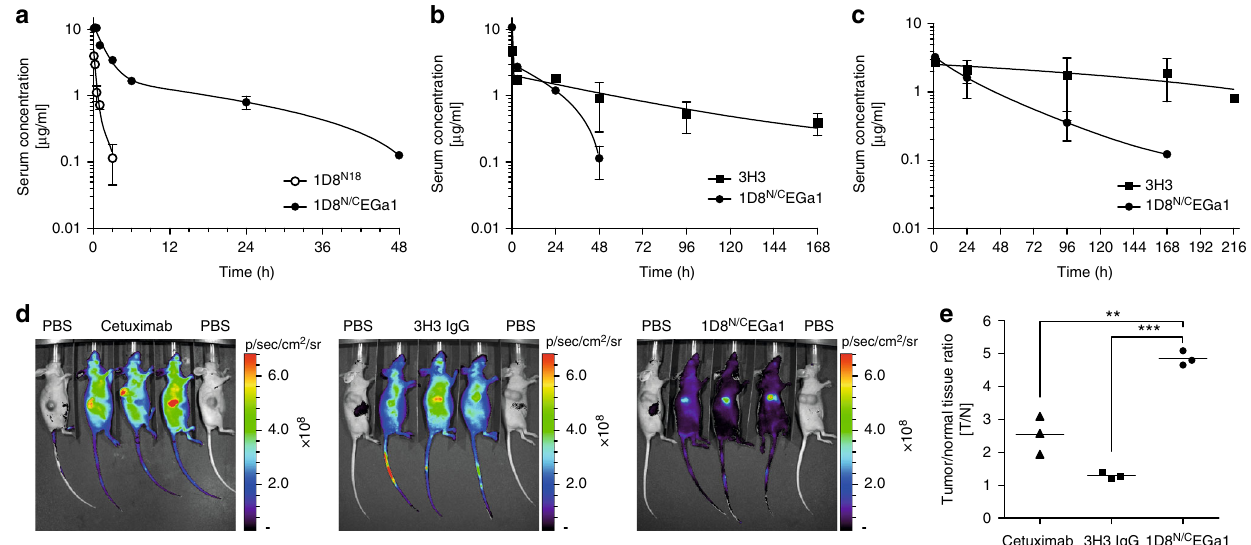
Fig. 4 Pharmacokinetic properties and tumor imaging of the EGFR-targeted 4-1BB-agonistic trimerbody. Pharmacokinetic studies after a single i.v. dose (1 mg/Kg) of 1D8 N18 or 1D8 N/C EGa1 in CD-1mice ( a ) or of 3H3 IgG or 1D8 N/C EGa1 in BALB/c mice ( b ). Pharmacokinetic study after a single i.p. dose (1 mg/Kg) of 3H3 IgG or 1D8 N/C EGa1 in BALB/c mice ( c ). d In vivo fl uorescence imaging of A431 tumor-bearing nude mice 24 h after i.v. injection of PBS or 100 µ g of Cy5-labeled cetuximab, CF647-labeled 3H3 IgG or CF647-labeled 1D8 N/C EGa1. e Tumor to normal tissue (T/N) ratios. The color scale bar represents the fl uorescence intensity recorded as photons per second per centimeter squared per steradian (p/s/cm 2 /sr). Data are mean ± SD ( n = 3), ** P ≤ 0.01, *** P ≤ 0.001, Student's t